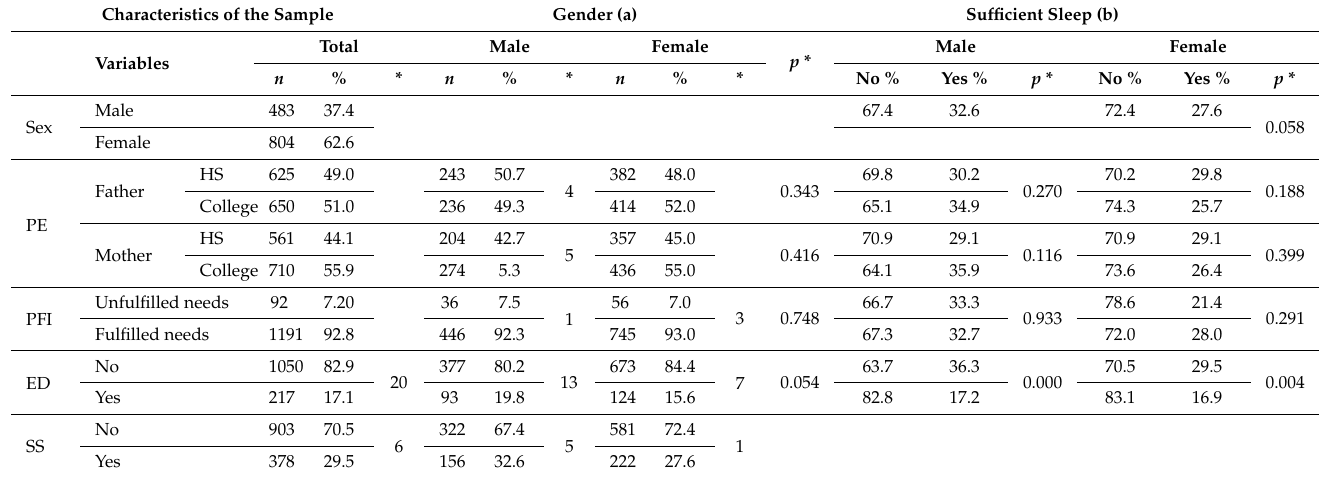
Table 1. Bivariate association between: characteristics of the sample and gender (a); characteristics of the sample and sufficient sleep (b) stratified by gender ( n =